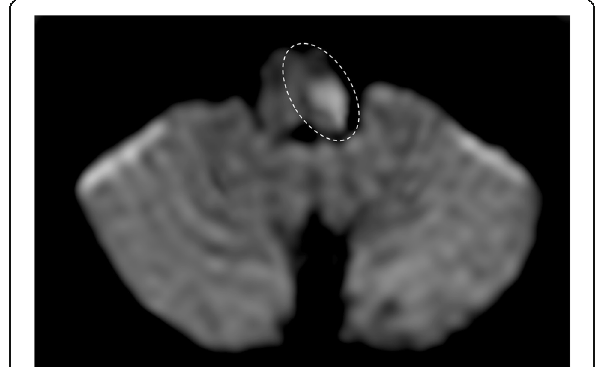
Fig. 31 Wallenberg syndrome. Patient with left sensory loss, gait ataxia, nausea, and vertigo. MRI DWI (b1000) image demonstrates area of diffusion restricted in the left dorsal medulla oblongata, suggestive for recent ischemic lesion (dotted